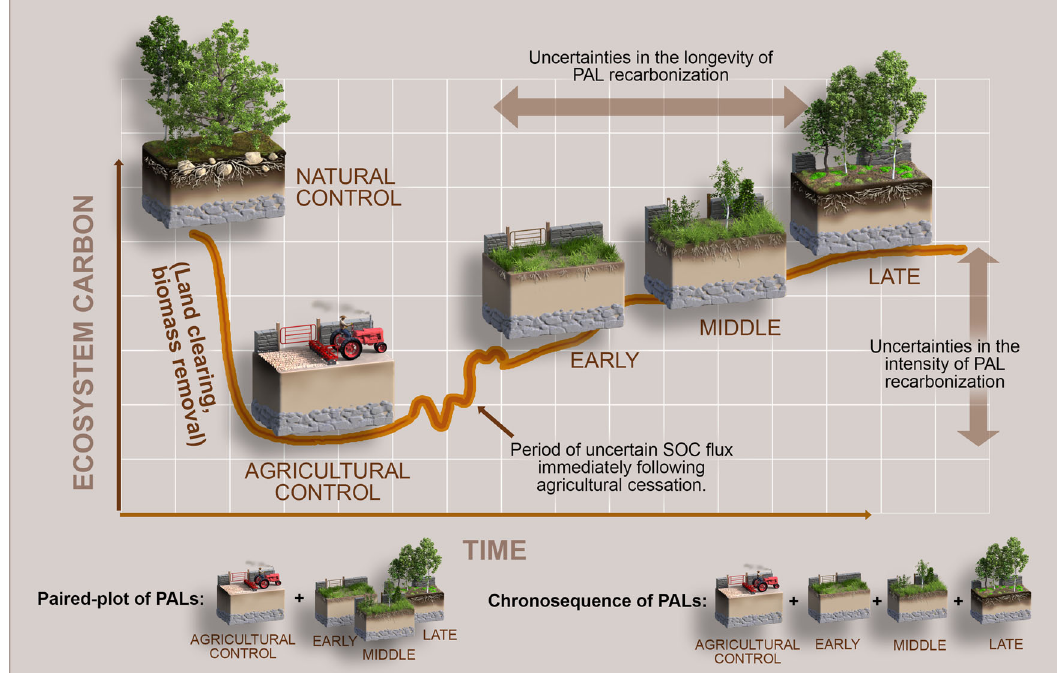
Fig. 1 | Typical post-agricultural landscape (PAL) trajectory involving land clearing from the primary forest (natural control) for agricultural use (agri- cultural control) and ecological succession following agricultural cessation (shown here as early-, middle-, and late-stage PALs). The rebuilding of ecosys- tem carbon stocks in PALs is represented by the increasingly darkening top soils andgrowingplantbiomass.However,theecologicalandstructurallegaciesofland clearing,tilling,andotherdestructivepracticeshavelastingimpactsonabove-and below-ground properties, preventing a rapid return to pre-disturbance